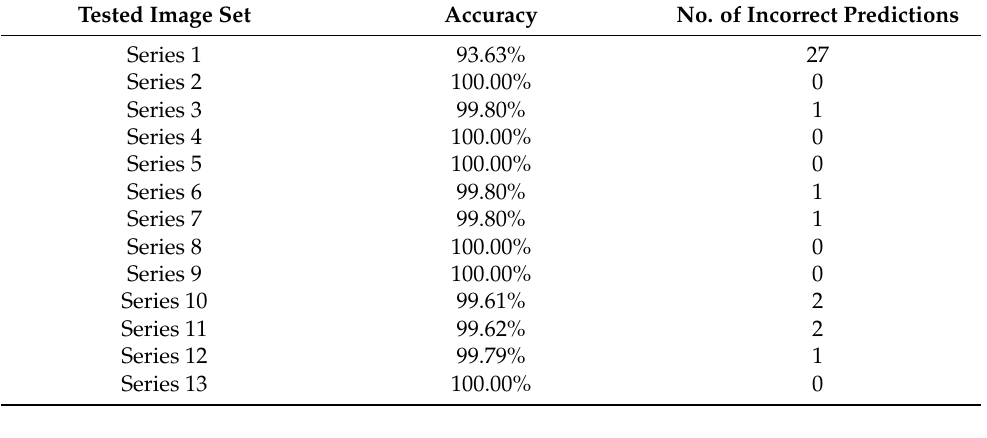
Table 11. Learning and test sets for 13 classifications 1 .